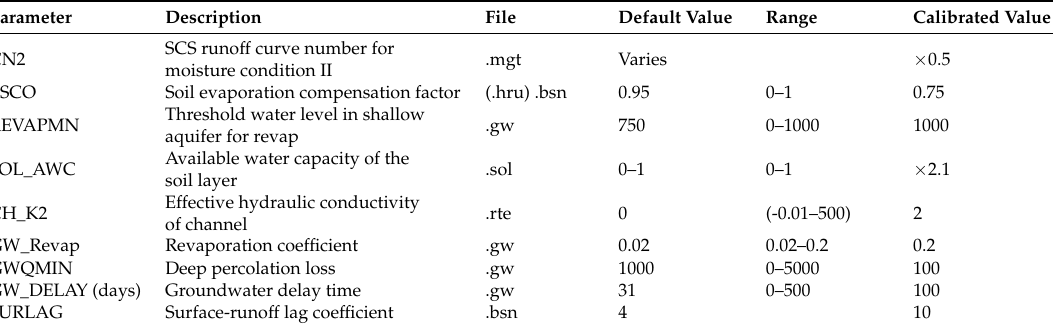
Table 2. Parameters used to calibrate the Upper Babocomari Watershed Model, where variant ranges of default values depend on